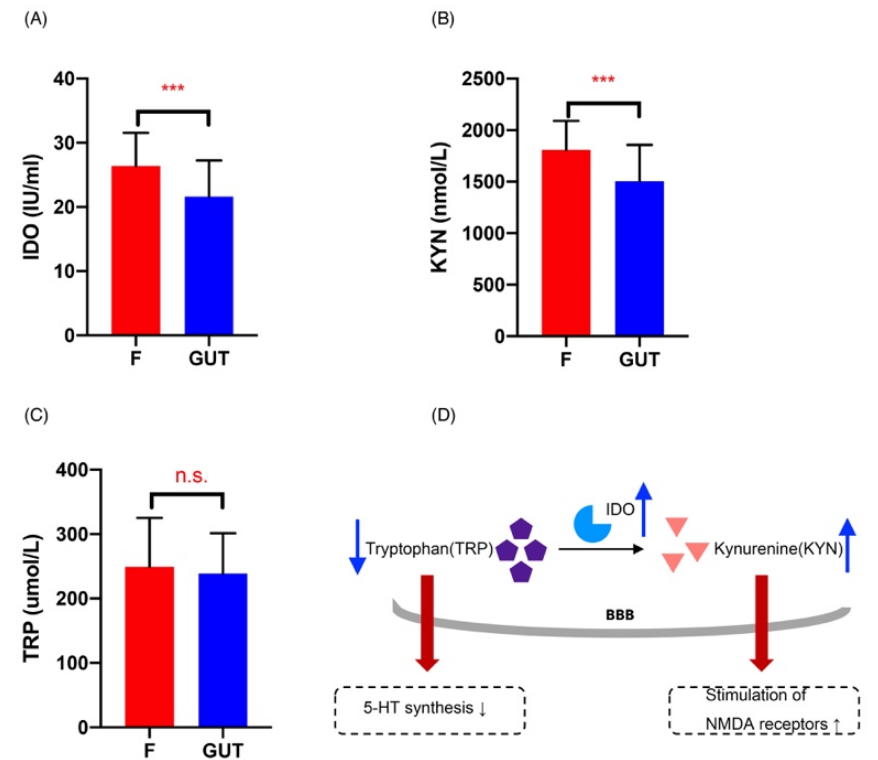
Figure 6. Changes in the Kyn pathway in MDD patients. Plasma Ido ( A ), Kyn ( B ), and Trp ( C ) concentrations in the MDD (F, red) and control (GUT, blue) groups, revealing significantly increased Ido ( A ) and Kyn ( B ) in MDD cases compared with the controls. ( D ) Summary of Kyn pathway changes in MDD patients: increased Ido activity induces Trp metabolism, resulting in: (i) increased production of Kyn that causes hippocampal damage and oxidative stress by overstimulating NMDA receptors, and (ii) the decreased availability of Trp that crosses the blood–brain barrier (BBB), leading to a reduced synthesis of 5-HT. Data are presented as the mean ± standard deviation. *** p < 0.01 versus the control group.